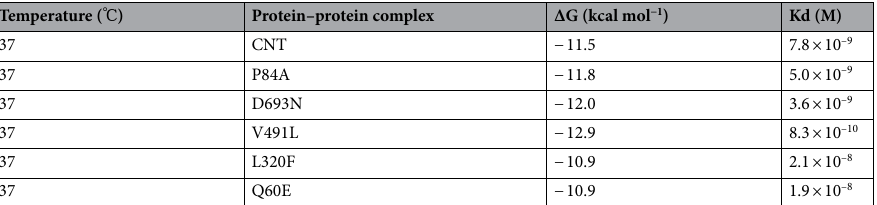
Number of interfacial contacts (ICs) per property Protein–protein complex